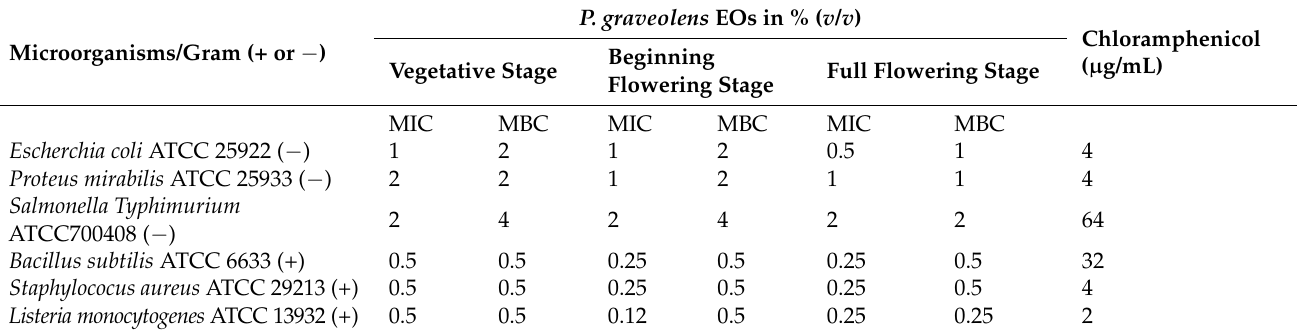
Table 3. MIC and MBC measured of PGEOs at three developmental